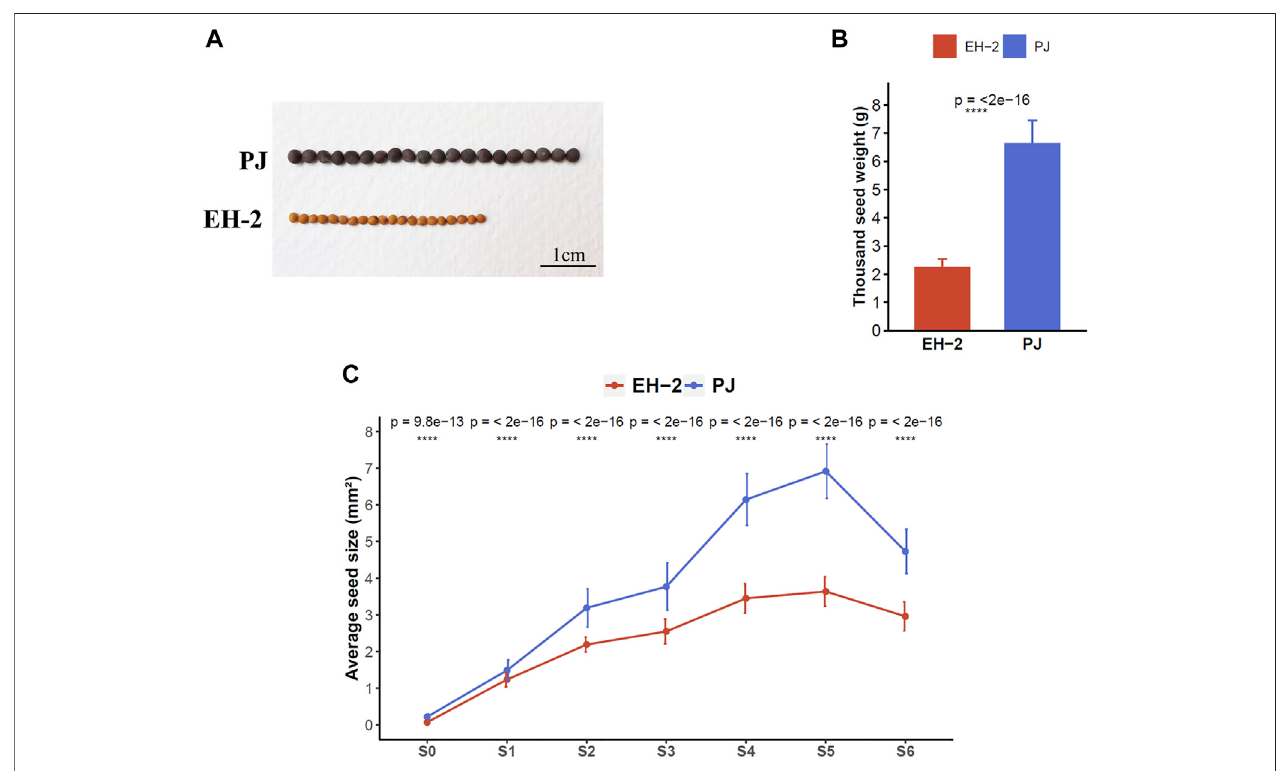
FIGURE 1 | Phenotypic comparisons between the Brassica juncea lines EH-2 and PJ. (A) Comparisons in seed size and coat color in mature seeds of EH-2 and PJ. (B) Comparison of Tsw in mature dry seeds (S6) of EH-2 and PJ. (C) Differences in the average seed size of EH-2 and PJ seed sampled at stages S0 – S6. Tsw, thousand seed